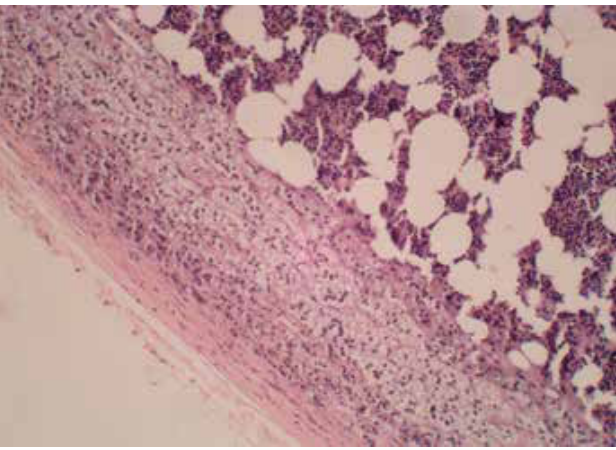
figuRE 4 − Presence of zona fasciculata of the adrenal cortex of ordinary aspect around the lesion and fibrous pseudocapsule (20× magnification)